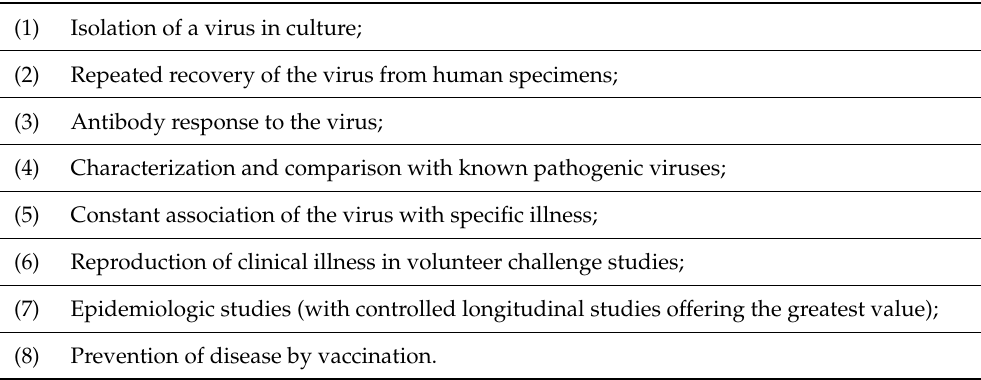
Table 2. Robert Huebner’s 1957 Bill of Rights for Prevalent Viruses [1].